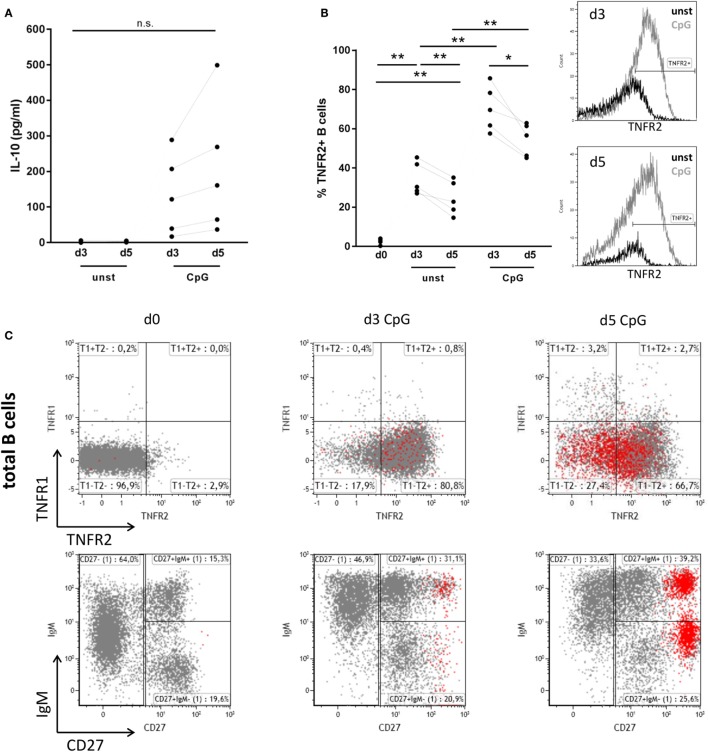
Interleukin-10 (IL-10) production, tumor necrosis factor receptor 2 (TNFR2), and tumor necrosis factor receptor 1 (TNFR1) expression after CpG ODN stimulation of B cells. Freshly isolated B cells (d0) and on days 3 and 5 after stimulation with CpG ODN were studied for (A) IL-10 production in supernatants (n = 5 independent donors) and (B) TNFR2 expression on unstimulated and stimulated B cells (n = 5 independent donors). The histograms for TNFR2 expression are shown as an overlay on days 3 and 5 with marker placed based on level of isotype control fluorescence. The graph summarizes the results from n = 5 independent donors (*p < 0.05, **p < 0.01, n.s., not significant). (C) TNFR1 and TNFR2 expression on total CD19+ B cells was analyzed by flow cytometry in freshly isolated B cells (d0) and on days 3 and 5 after stimulation with CpG ODN. CD38high CD27high plasma blasts are highlighted in red. The lower panel shows the phenotype profile of CpG-stimulated B cells based on IgM and CD27 markers. Results from one representative of four independent donors are depicted.